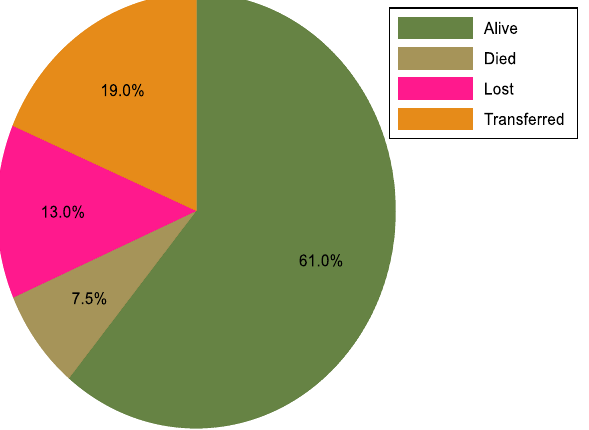
Figure 2. Treatment outcomes of adults living with HIV on ART at Debre Markos Comprehensive Specialized Hospital, Northwest Ethiopia, 2021.